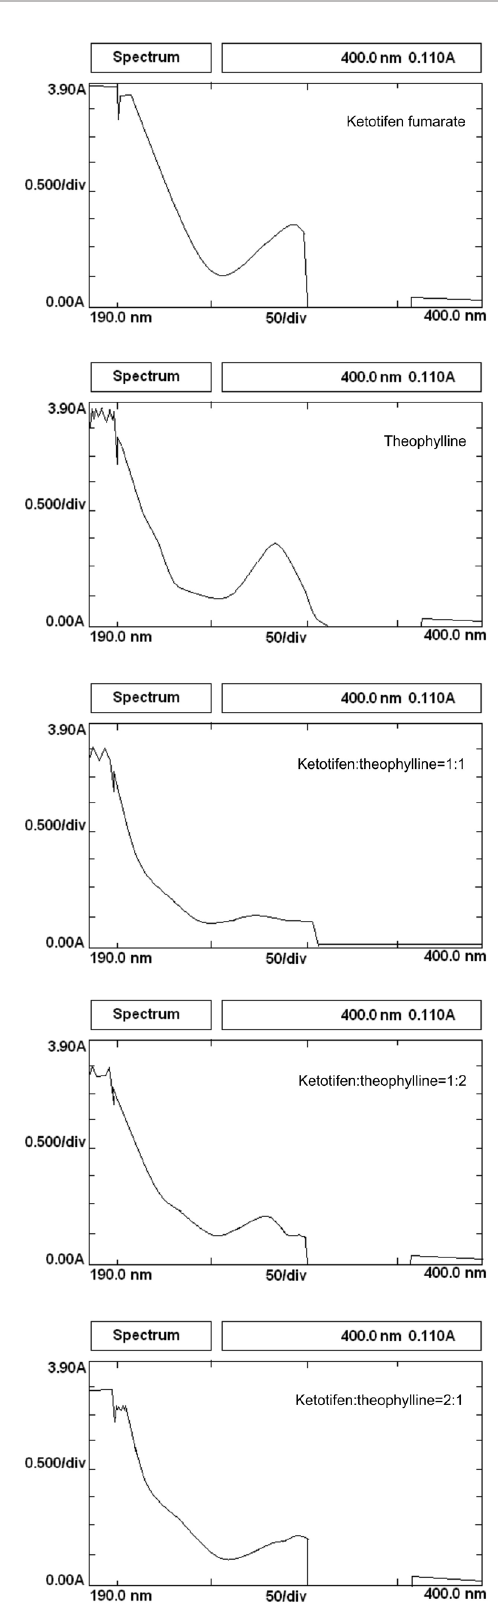
FIGURE 5 - Spectral studies of ketotifen fumarate and theophylline at pH 6.8 X axis: UV range; Y axis: